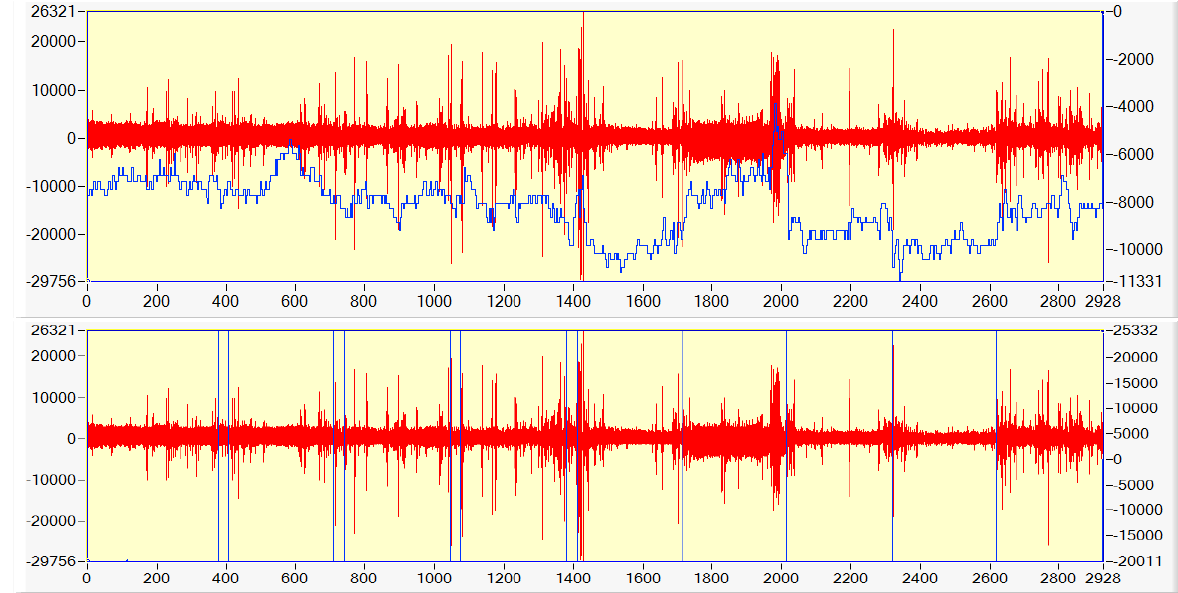
Fig. 1. Recording of a REG (red) and NIRS (blue) signals during sequence of tests (upper panel). Lower panel shows same REG signal and event markers indicating when a test started and ended (blue). Tests are as: breath holding, hyperventilation, CO 2 inhalation, Valsalva maneuver, Trendelenburg and Reverse Trendelenburg positions. Y-axis is in AD conversion units; X-axis is in seconds. Note the simultaneous amplitude increase of REG and NIRS signals during Trendelenburg position (1750-2000 s).